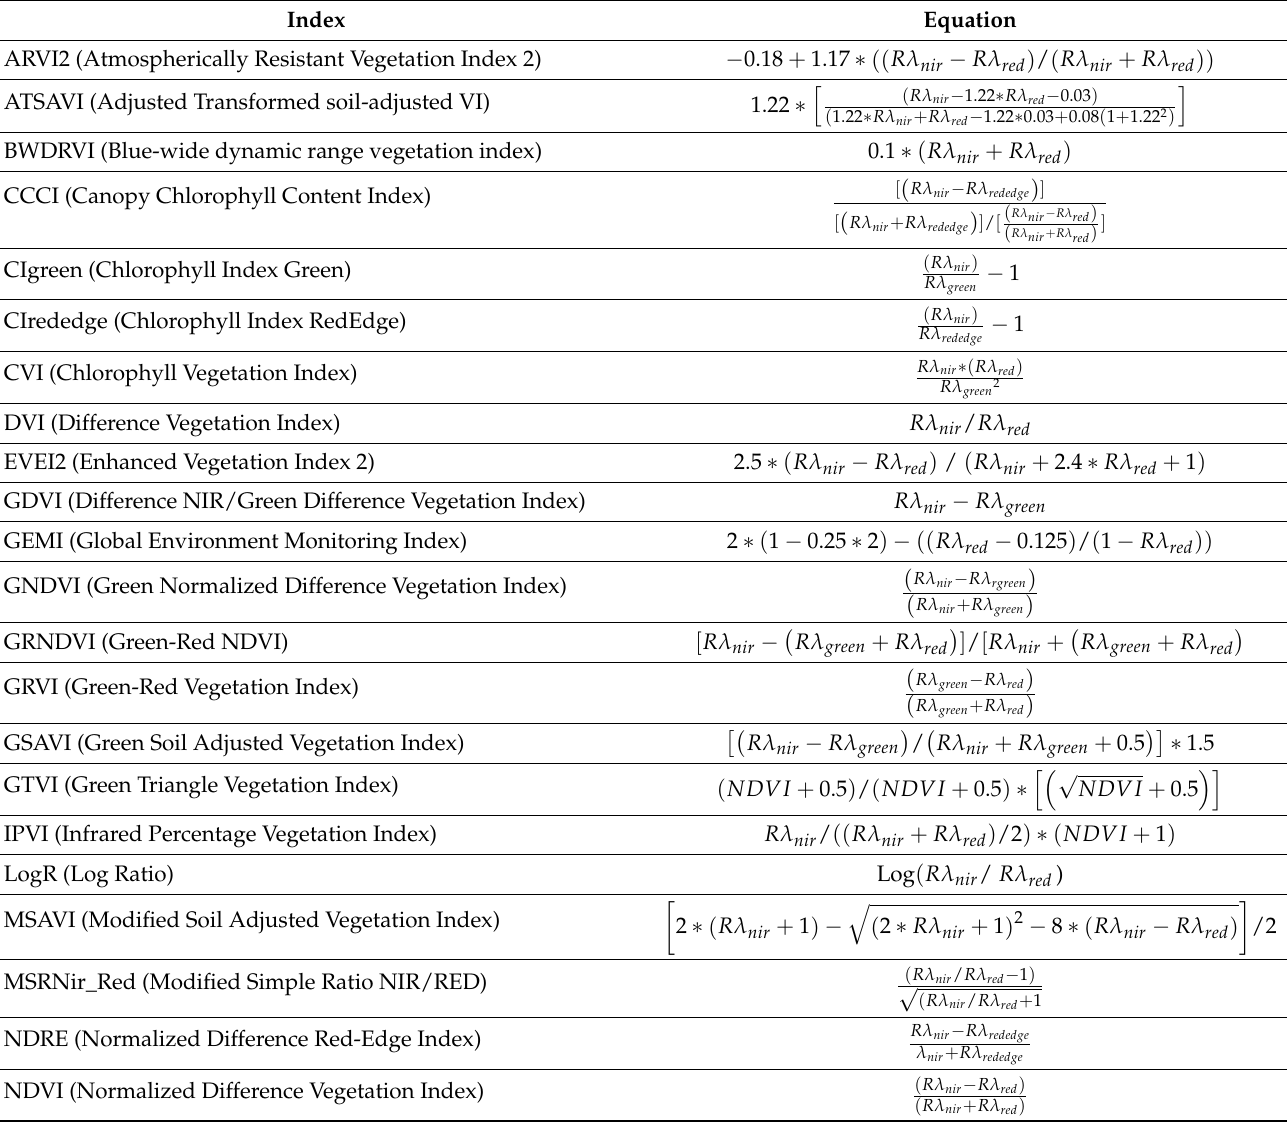
Table 1. Vegetation indices used in the